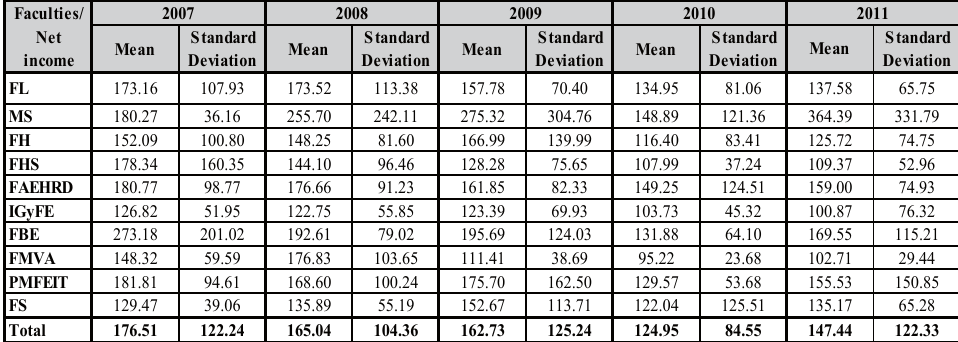
Table 2. The graduates’ net income in thousands of HUF, 2007-2011